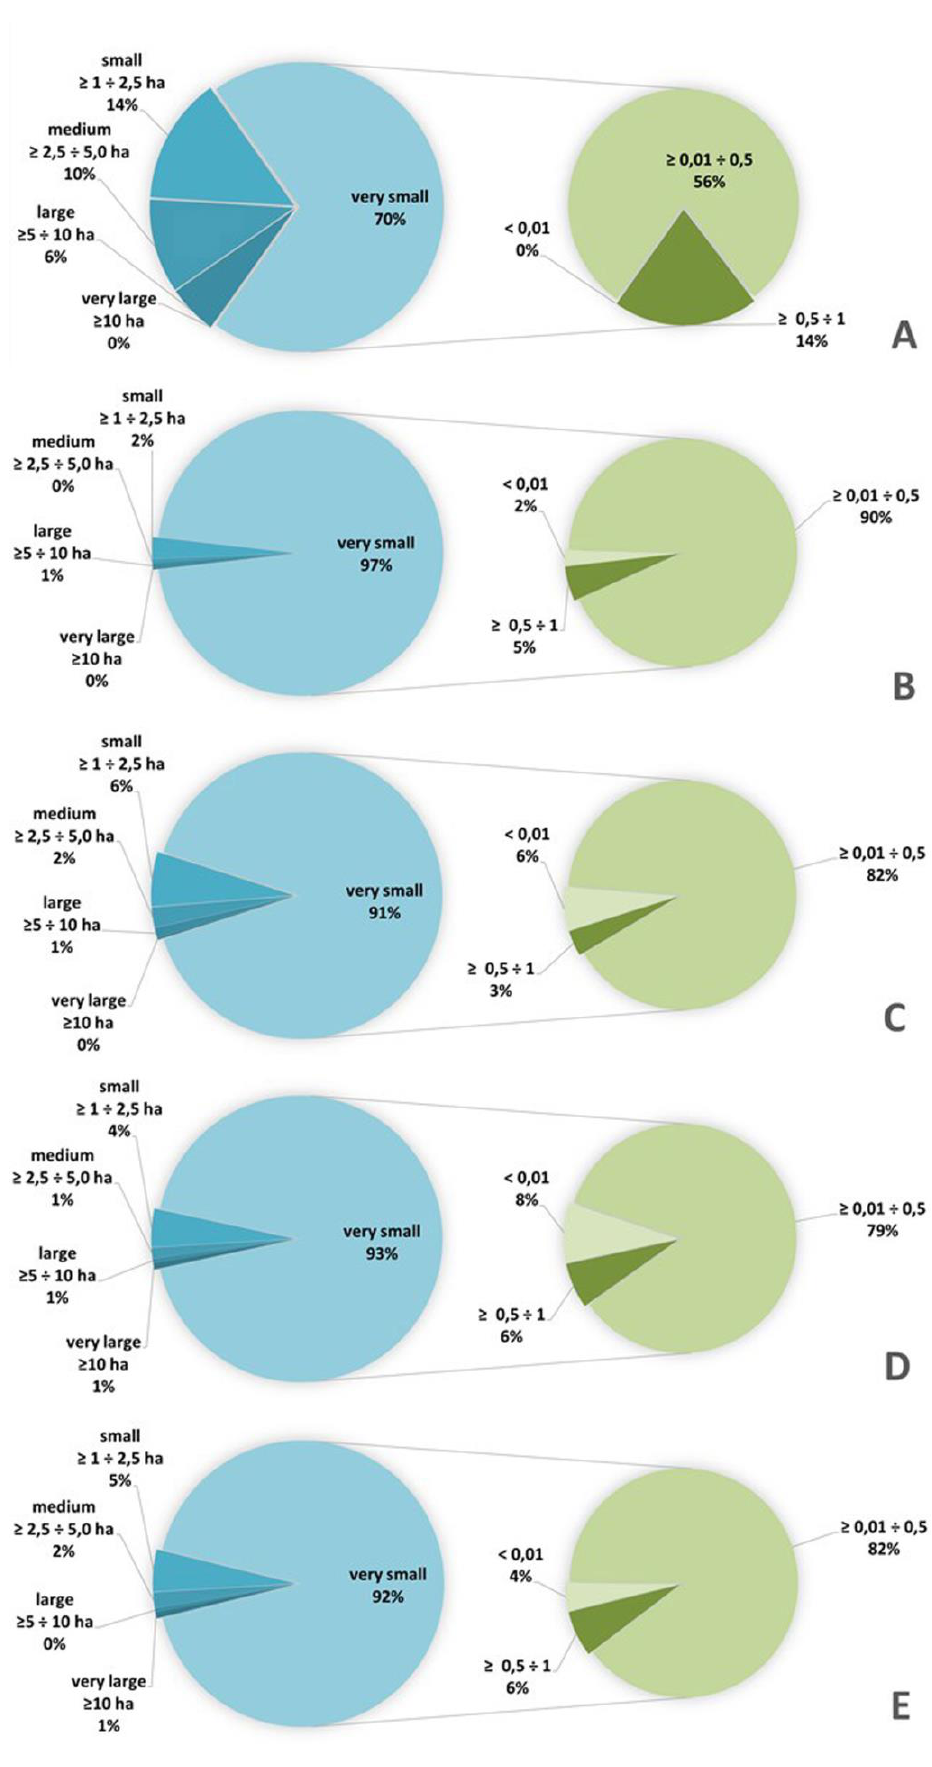
Fig. 4. Number of water bodies by their area (A – the beginning of the 19 th century, B – the end of the 19 th century, C – the beginning of the 20 th century, D the end of the 20 th century, E ¬ the beginning of the 21 st century; own study based on